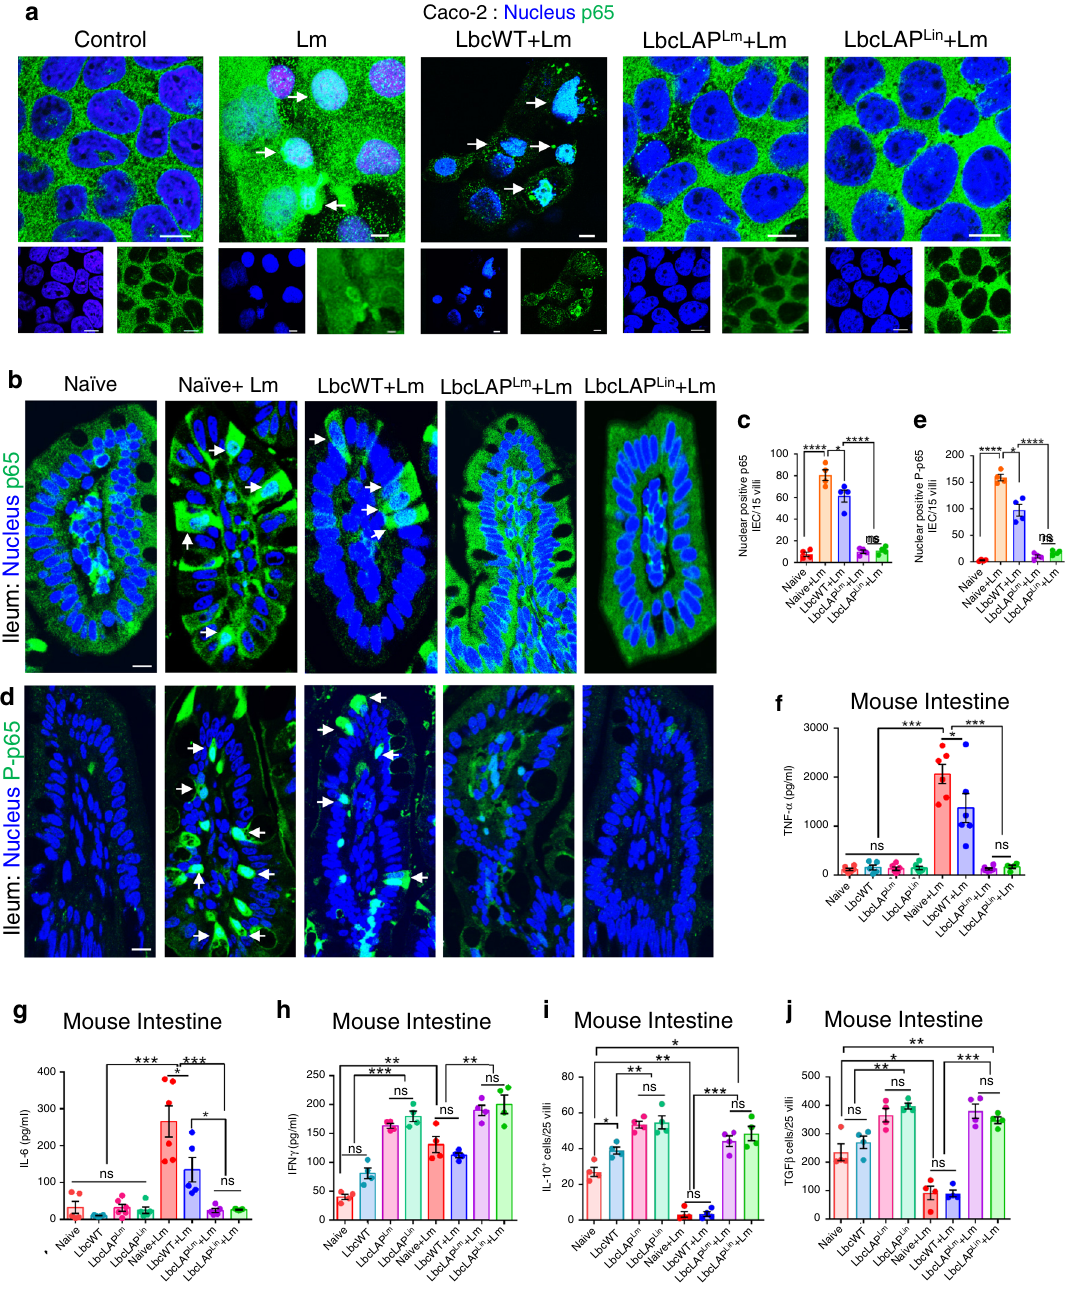
Fig. 8 BLP prevents Lm -induced NF- κ B activation and modulates cytokine production and immune cells to maintain intestinal immune homeostasis. a Immuno fl uorescence micrographs showing decreased nuclear localization of p65 ( a , green) in Caco-2 cells treated with BLP strains (MOE 10, 24 h) before Lm exposure (MOI 50, 1 h). Arrows indicate the nuclear localization of p65. Separated channels; bottom panels. Bars, 10 μ m. Images represent fi ve different fi elds from three independent experiments. b – e Immuno fl uorescence micrographs of the ileal tissues showing decreased nuclear localization of p65 ( b , green) and P-p65 ( d , green) in BLP-treated mice (10 days) at 48 hpi. Nuclei; DAPI, blue. Arrows indicate the nuclear localization of p65 ( b ) and P- p65 ( d ) in IEC of naive or LbcWT-treated (10 days) mice at 48 hpi. Right panels ( c , e ) show the quanti fi ed results (mean ± SEM) of p65 ( c ) and P-p65 ( d ) nuclear-positive IEC. Each point represents an average of 15 villi from a single mouse, four mice per group, n = 60 villi. Bars, 10 μ m. f , g , h ELISA showing decreased TNF α ( f , n = 6 mice for all groups, except LbcWT and LbcLAP Lin + Lm group; n = 5 and 4 mice, respectively), and IL-6 ( g , n = 5 mice for all groups except LbcWT, LbcLAP Lm and naive + Lm groups; n = 6 mice) levels (mean ± SEM) in the ileal tissues of BLP-treated (10 days) mice, relative to naive or LbcWT-treated (10 days) at 48 hpi and increased IFN γ ( h , n = 4) levels (mean± SEM) pre- or post- Lm challenge at 48 hpi. Each point; individual mouse. i , j Graphs showing increased IL-10 + ( i ) and TGF β + ( j ) cells quanti fi ed (mean± SEM) from immunostained ileal tissues (Supplementary Fig. 8h, i, respectively) of BLP-treated (10 days) mice pre- or post- Lm challenge at 48 hpi. Each point represents an average of 25 villi from a single mouse, four mice per group, n = 100 villi. Statistical signi fi cance ( c , e , f – j ) was determined by using the one-way ANOVA followed by a Tukey ’ s multiple comparisons. For all analysis, **** P < 0.0001; *** P < 0.001; ** P < 0.01; * P < 0.05; ns no signi fi cance. Source data are provided as a Source Data fi